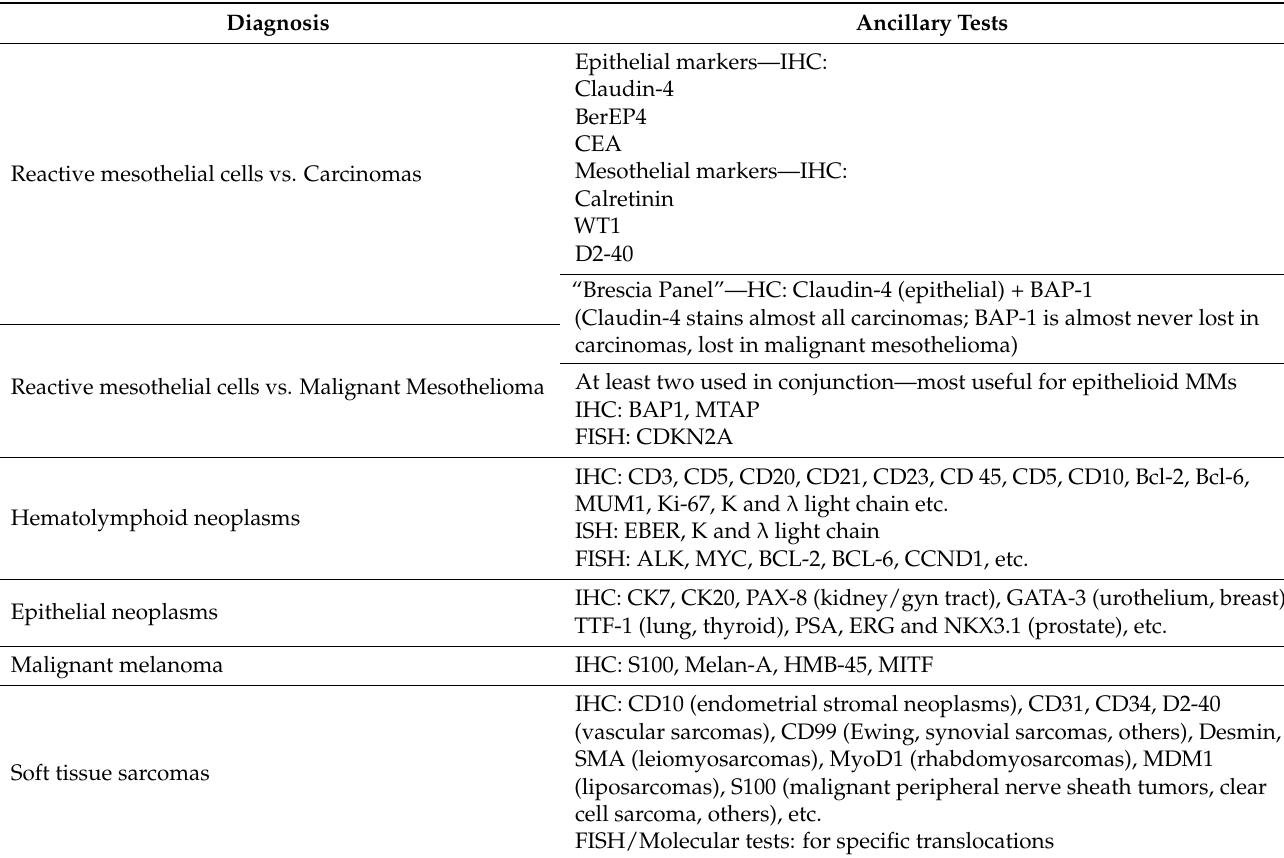
Table 1. Ancillary tests that may be used in the context of AUS, SFM or MAL for diagnostic purposes in serous effusion samples *.